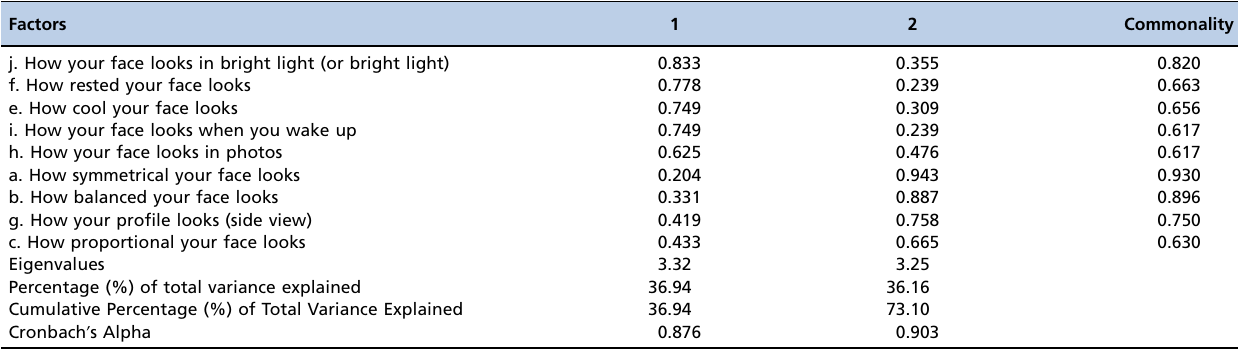
Varimax Rotation. KMO=0.832.